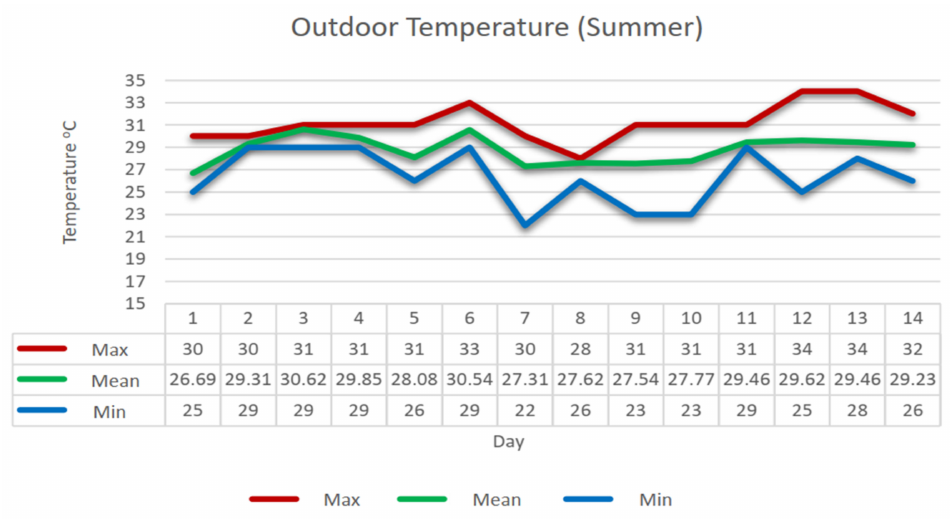
Figure 7. Outdoor temperature